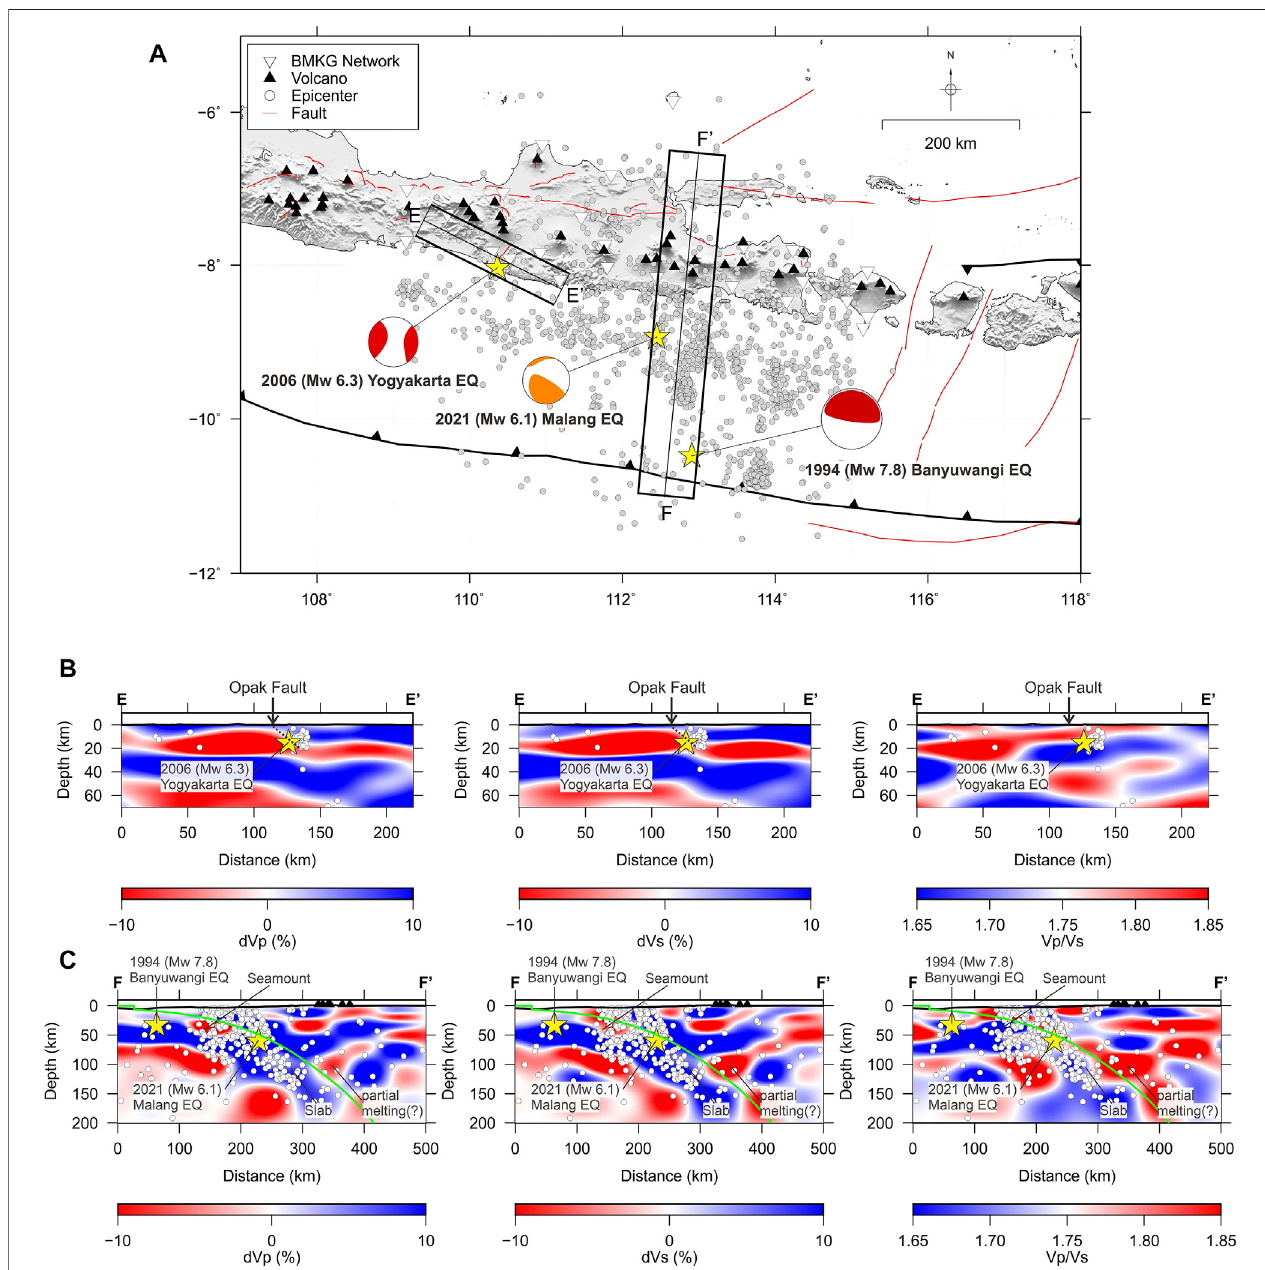
FIGURE 8 | (A) Map of the large earthquake epicenters (yellow stars) and the seismicity (gray circles) used in this study. Focalmechanism solutions are taken from GCMT((https://www.globalcmt.org/)TherectanglesEandFaretheareausedtoplottheverticalcross-sectionin Figure8B , Figure8C .Twobottom fi guresarevertical sectionsforVp,Vs,andVp/Vsratiowithrelocatedseismicityacross (B) the2006Yogyakartaearthquake(Mw6.3) (E-E 9 ) , (C) the1994Banyuwangiearthquake(Mw7.8) and the 2021 Malang earthquake (F-F 9 ) . Green lines indicate the slab 2.0 model (Hayes et al., 2018). Black triangles show locations of volcanoes.